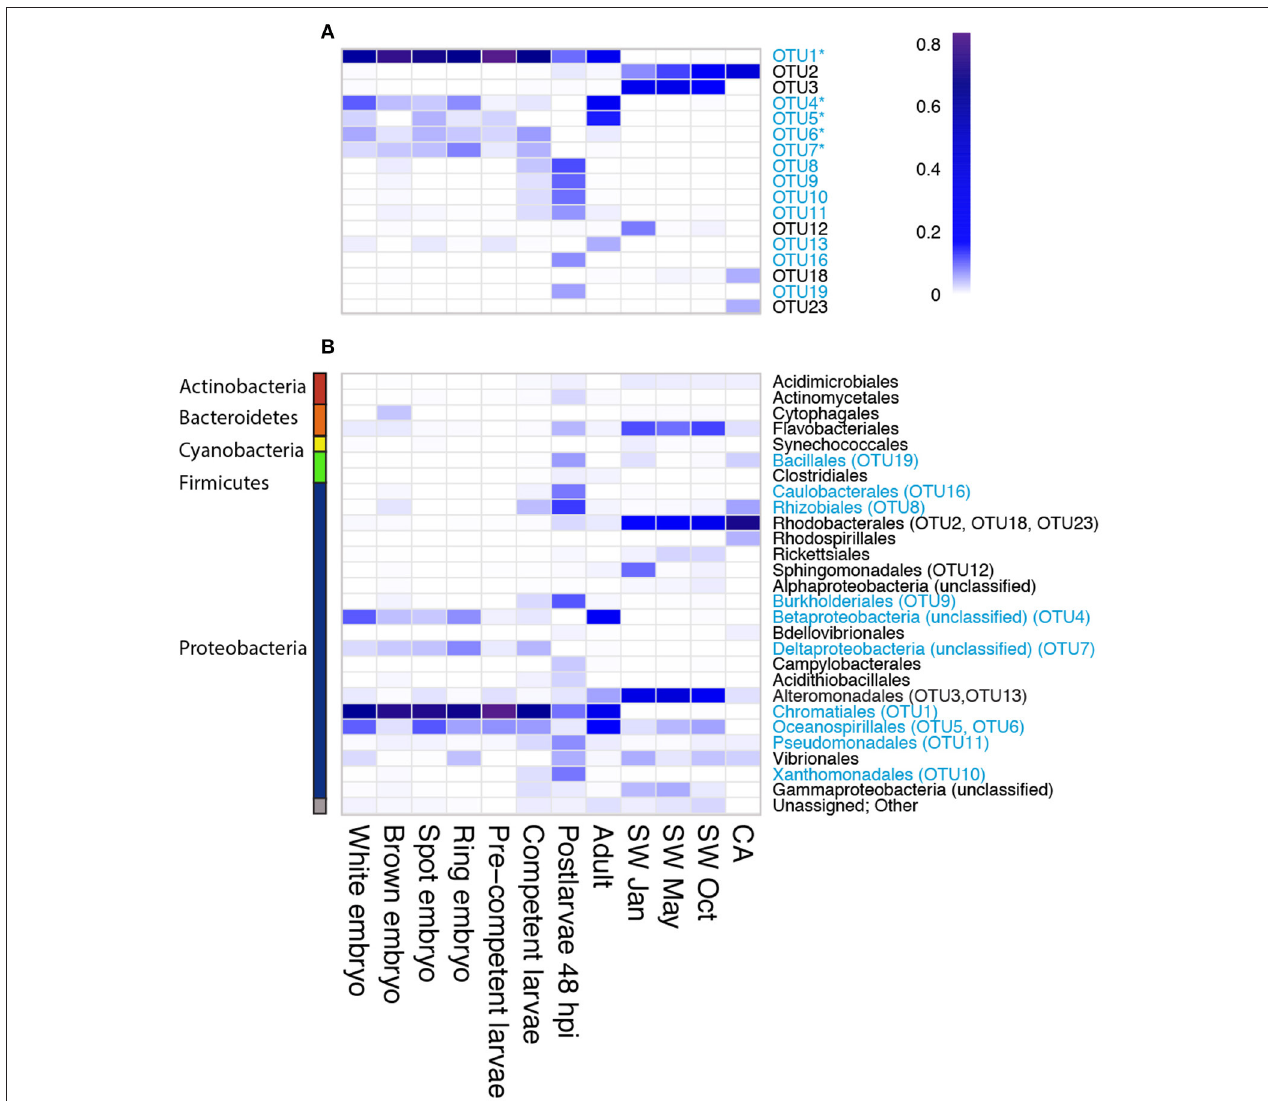
FIGURE 3 | Heatmap depicting relative OTU abundance at (A) OTU level for the most abundant OTUs (relative abundance ≥ 5% within any sample), and (B) order level for all OTUs. The dominant sponge microbionts (relative abundance ≥ 5% within at least one developmental stage) are indicated in blue. Amongst these, the putative vertically-inherited symbionts (defined as being present in more than half of the developmental stages sampled) are indicated with an asterisk. The order with which each of the most abundant OTUs was affiliated by the program QIIME is indicated in (B) . The color scale (0–0.8) indicates percent of total reads assigned to a particular bacterial OTU (panel A ) or bacterial order (panel B